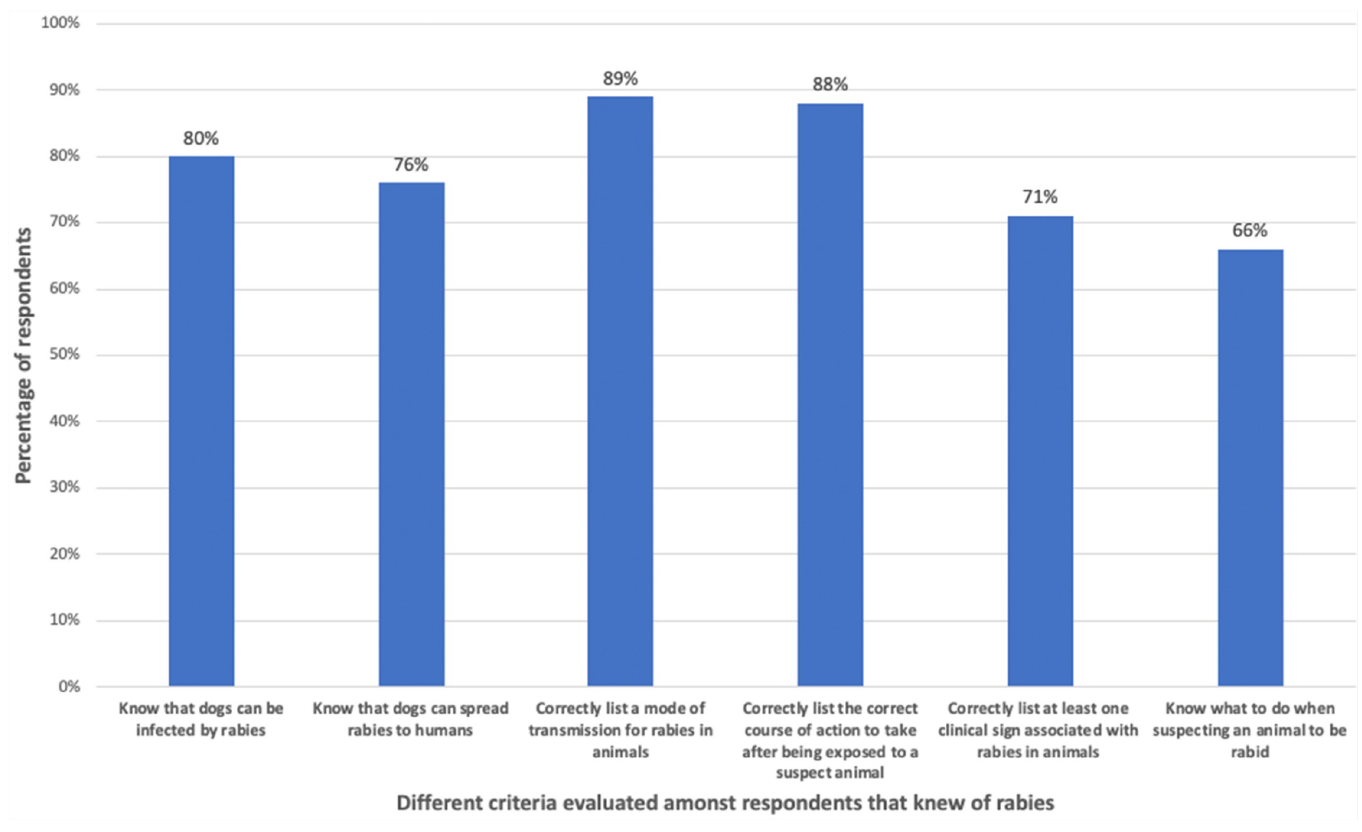
Fig 2. Knowledge of respondents that knew of rabies, disaggregated by different knowledge criteria.